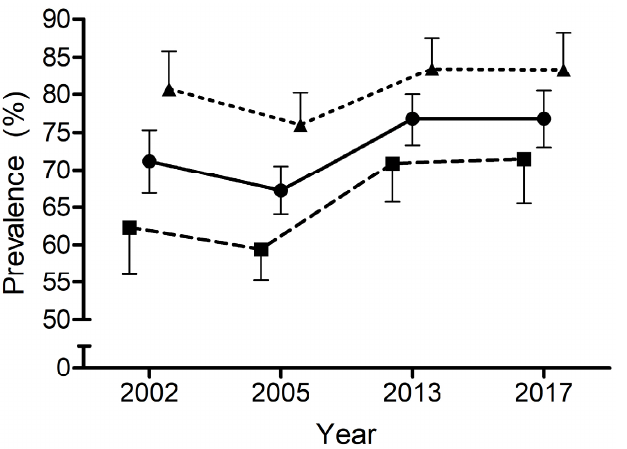
Figure 1. Physical inactivity levels of European Adolescents (boys, girls, and whole sample) in the four studied time points. Levels (%) of physical inactivity (reporting < 60 min/day of moderate to vigorous physical activity on average) among European Union Adolescents (in circles, the whole sample; in triangles, the girls’ sample; and in squares, the boys’ sample) for four different time points (2002, 2005, 2013, and 2017). Data are means ± CI. Table 1. Levels (%) of physical inactivity (PIA) in adolescents (15–17 years old) in the European Union (EU) countries in 2002, 2005, 2013, and 2017.